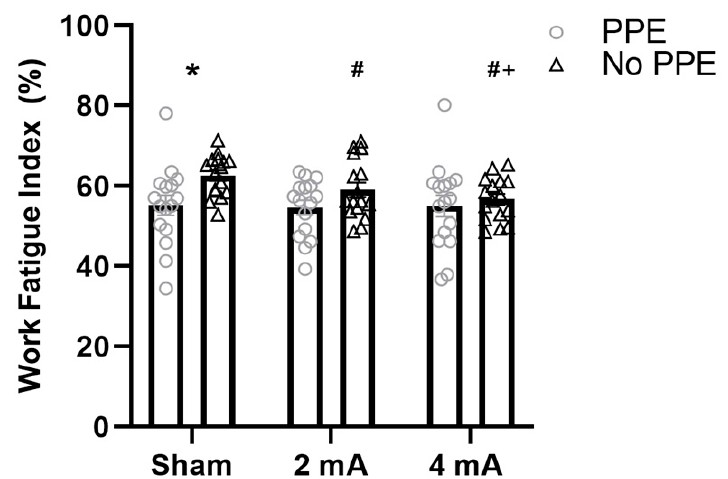
Figure 2. Fatigue index derived from the work data for the right knee extensors stratified by tDCS condition (sham, 2 mA, and 4 mA) and study (PPE vs. No PPE). * Significantly smaller (i.e., increased fatigability) than the No PPE study (Workman et al., 2020 [6]) in the same tDCS condition (sham). # Significantly smaller (i.e., increased fatigability) than sham in the same study (No PPE). + Significantly smaller than the 2 mA condition in the same study (No PPE).